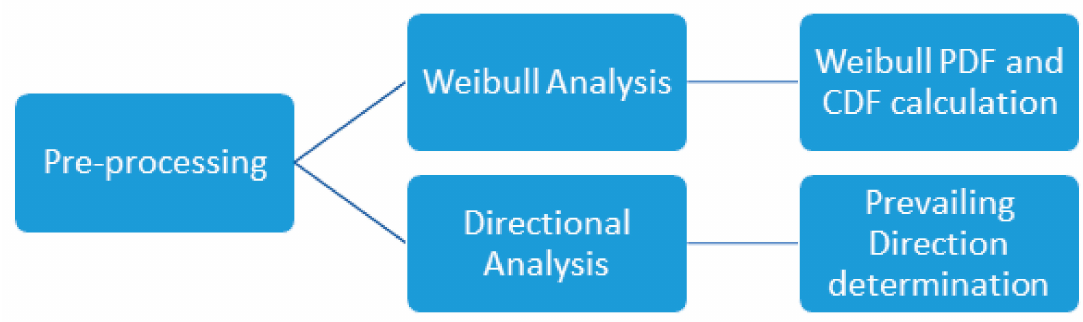
Figure 3. Program structure. CDF: cumulative density function, PDF: probability distribution